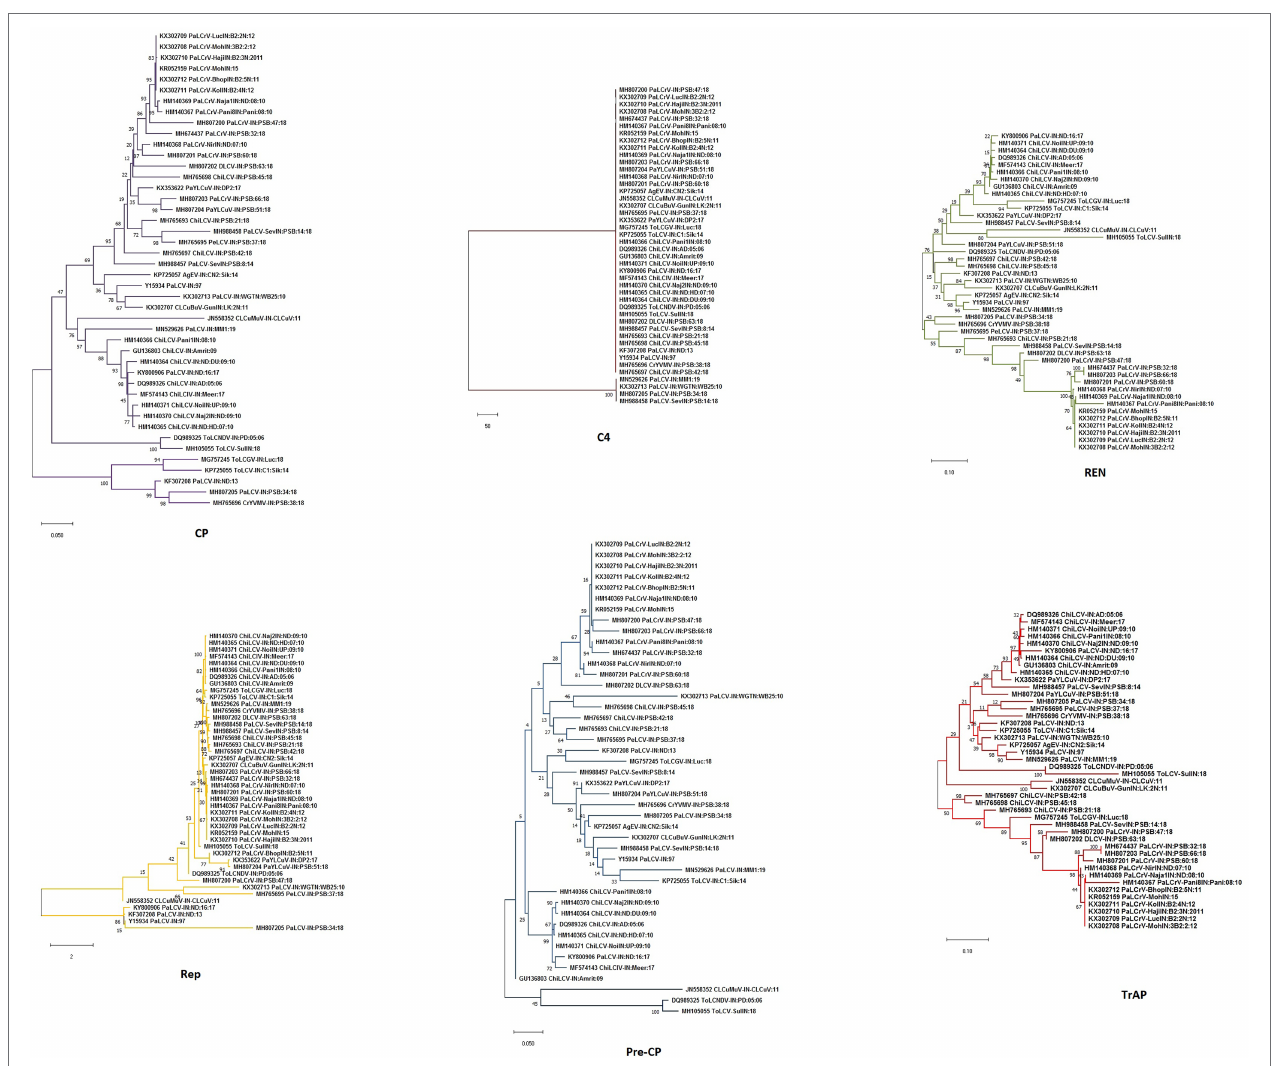
FIGURE 7 | Maximum-likelihood phylogenetic dendrogram of all the six genes/ORFs of begomoviruses associated with PaLCD in India aligned using CLUSTAL W with a 1,000 bootstrap value within the MEGA v.10 program; six ORFs (CP; C4; REn; Rep; Pre-CP; and TrAp) of 44 begomovirus